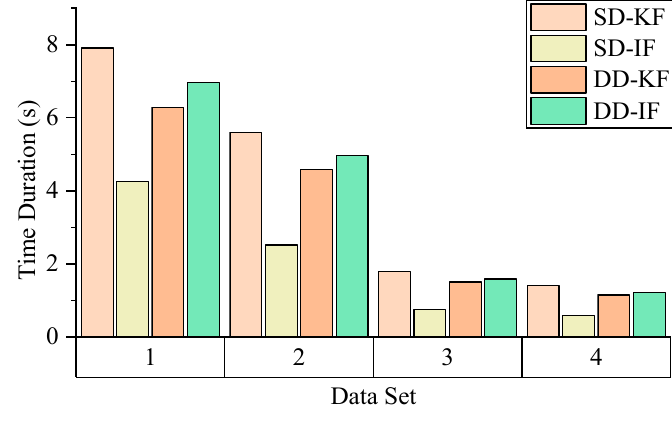
Figure 9. Overall time cost.